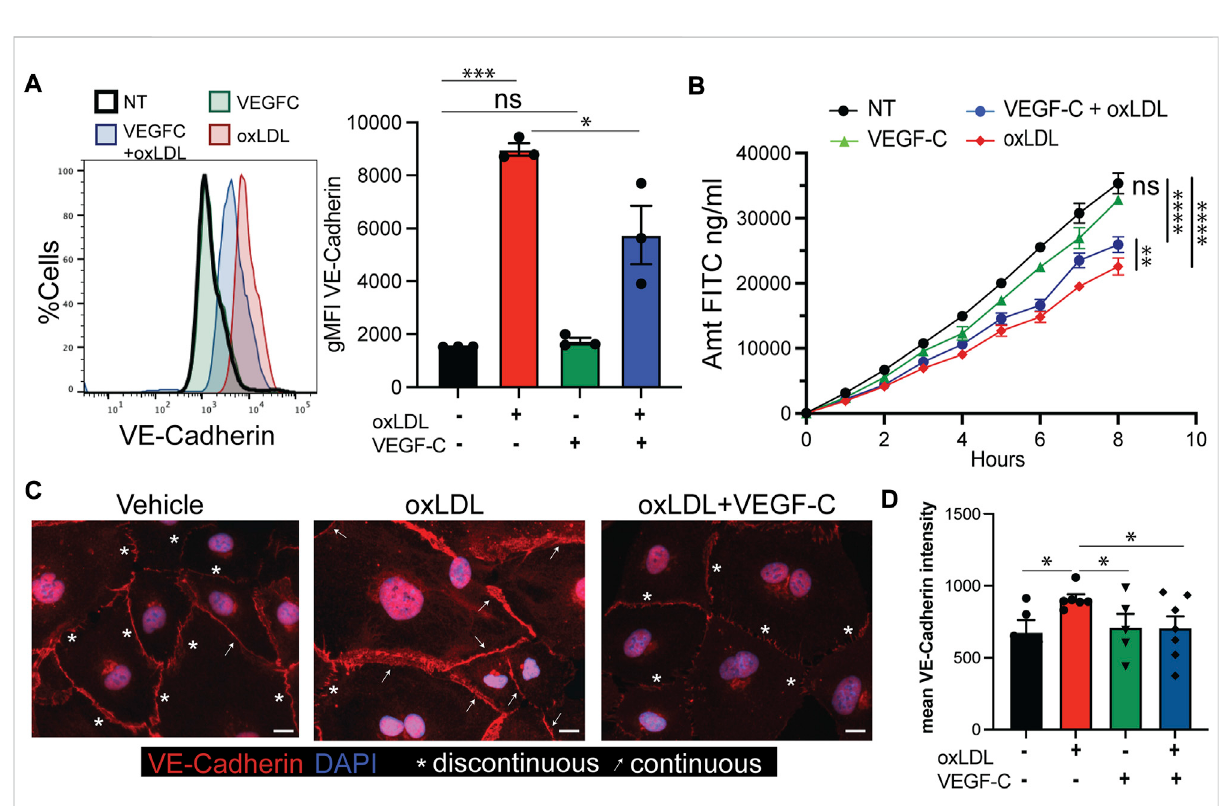
FIGURE 3 Vascular endothelial growth factor C and D reverse lymphatic speci fi c changes caused by oxLDL. (A) Histogram of VE-Cadherin surface expression on LECs treated with PBS or VEGF-C (Cys 156 → Ser mutant) for 16 h prior to addition of oxLDL or PBS for 4 h before harvest and staining with BV9 clone of VE-Cadherin. Bar graph representative of gMFI of VE-Cadherin in LECs with above treatments and ANOVA analysis demonstrated in a signi fi cant difference between oxLDL and oxLDL + VEGF-C. This experiment was repeated three times with 2-3 replicates per group with similar results. (B) Transwell experiment with LECs plated to con fl uency as described, treated for 16 hwith PBS or VEGF-C (Cys 156 → Ser mutant) then oxLDL or PBS for 4 h prior to addition of 1.25 mg/ml of 500 kDa FITC-dextran to the top chamber with measurement of FITC migrated to the lower chamber. Shown is quanti fi ed amount of FITC in bottom well. Linear regression performed and difference between slopes of oxLDL vs. oxLDL + VEGF-C groups was signi fi cant. Experiment was repeated two times with 3-4 replicates per group with similar results. (C) hLECs were plated, grown to con fl uence and treated with oxLDL ± VEGF-C as in (A , B) . Cells were stained with VE-Cadherin (Red), Dapi, blue and labeled based on junctional structures to have continuous (arrow) or discontinuous (asterisk) VE-Cadherin staining. (D) Quanti fi cation of mean fl uorescence intensity of VE- Cadherin. Dots represent blindly selected individual regions of each slide in order to minimize differences in con fl uence, staining within slides and across slides. Experiment was repeated 2 – 5 times (depending on treatment) with 2 – 3 separate chambers per group with similar results. * p < 0.05, *** p <